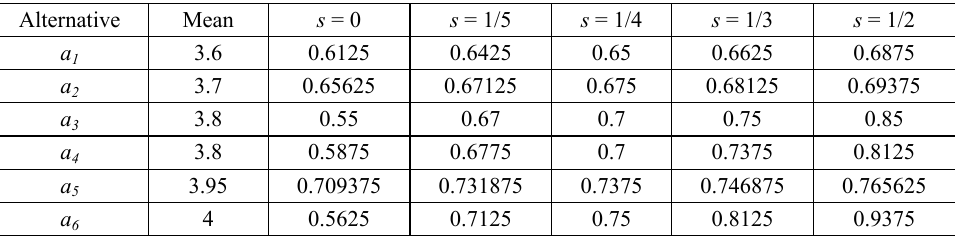
Table 9 Expected utility calculated using different cubic